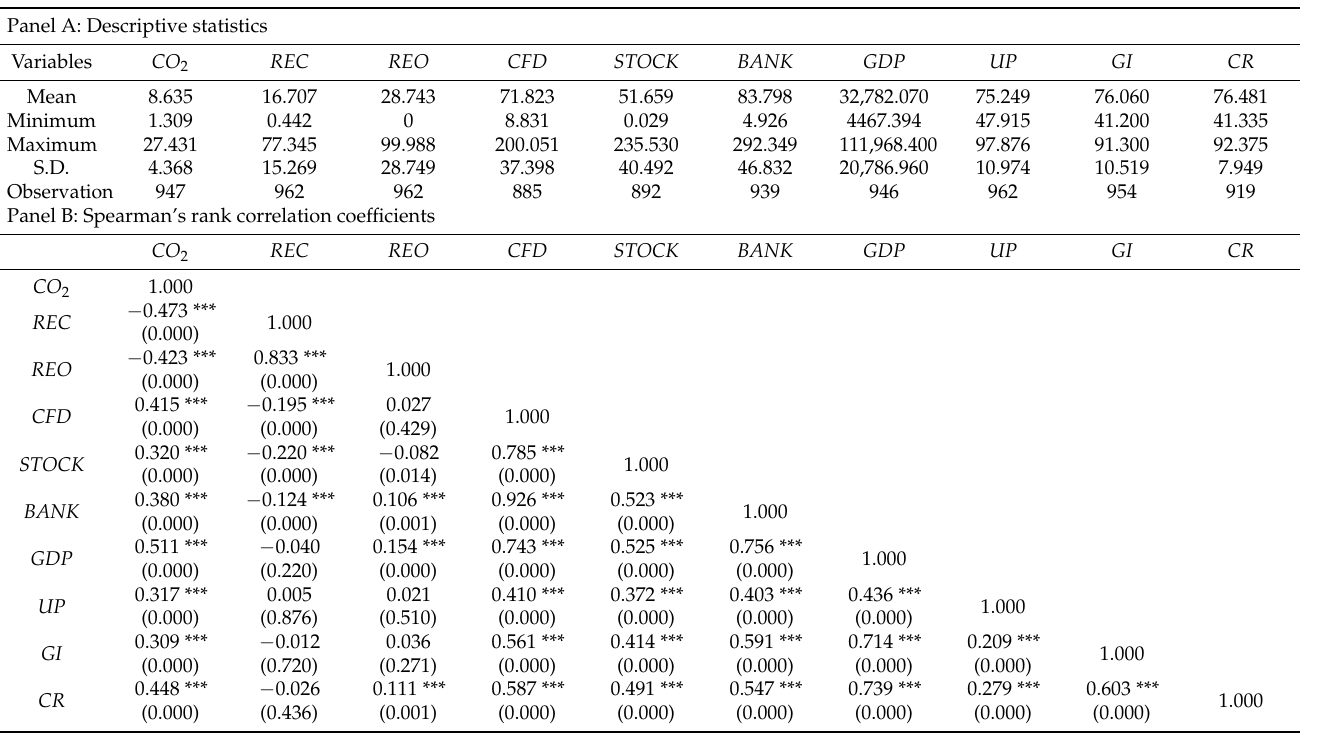
Table 2. Descriptive statistics and correlation coefficients of variables.